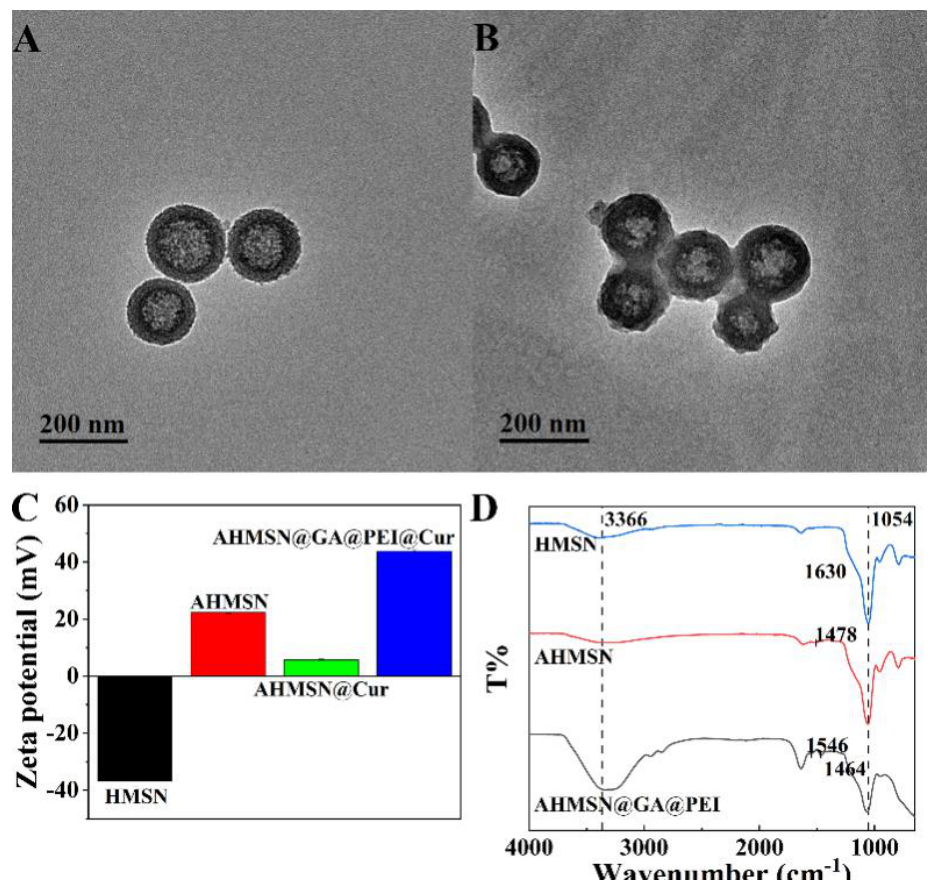
Figure 1. Characterizations of the synthesis and modification of the nanomaterials. ( A ) TEM image of AHMSN, the diameter of AHMSN is about 155 nm; ( B ) TEM image of AHMSN@GA@PEI, the diameter of AHMSN@GA@PEI is about 176 nm; ( C ) Zeta potentials of HMSN (-36.73 mV), AHMSM